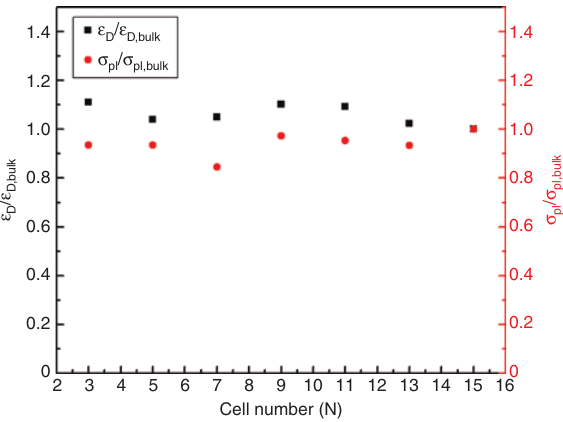
Figure 10 The plateau stress and the densification strain of seven kinds of honeycomb specimens with different in-plane size compressed in x -direction, normalized by the bulk value, plotted 2 against cell number, N